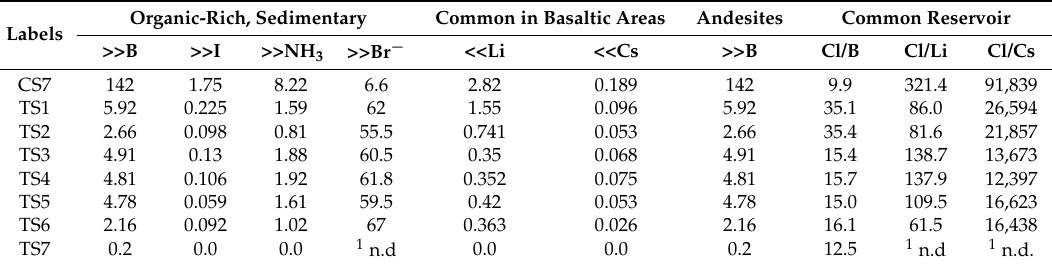
Table 2. Solute geoindicators for fluid origin analysis based on